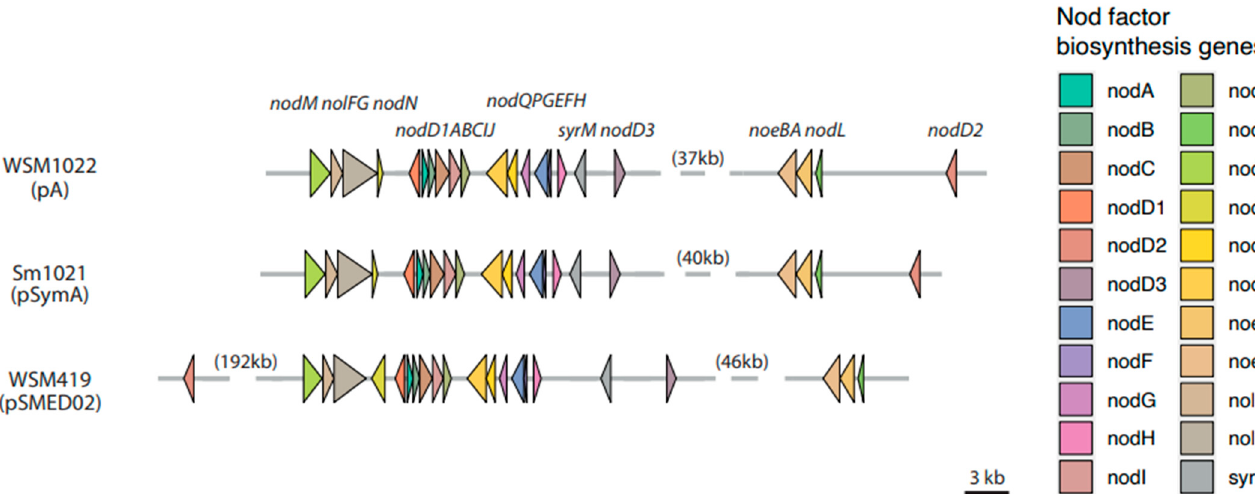
Figure 3. Conserved arrangement of Nod factor biosynthesis genes in plasmids of the three strains. Arrows indicate the genes encoding Nod factor biosynthesis genes present. Numbers in parentheses indicate distances between clusters of genes.